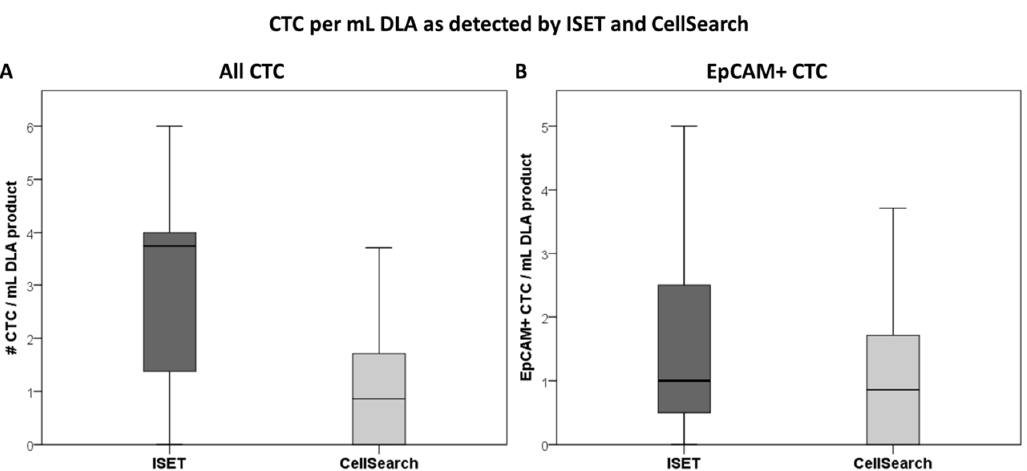
Figure 2. Boxplot depicting the median number of CTC / mL diagnostic apheresis product as identified by ISET (CTCs defined as either expressing TTF1 / p40 or EpCAM, while lacking CD45) and CellSearch. All CTCs ( A ) and only those expressing EpCAM ( B ) are considered.